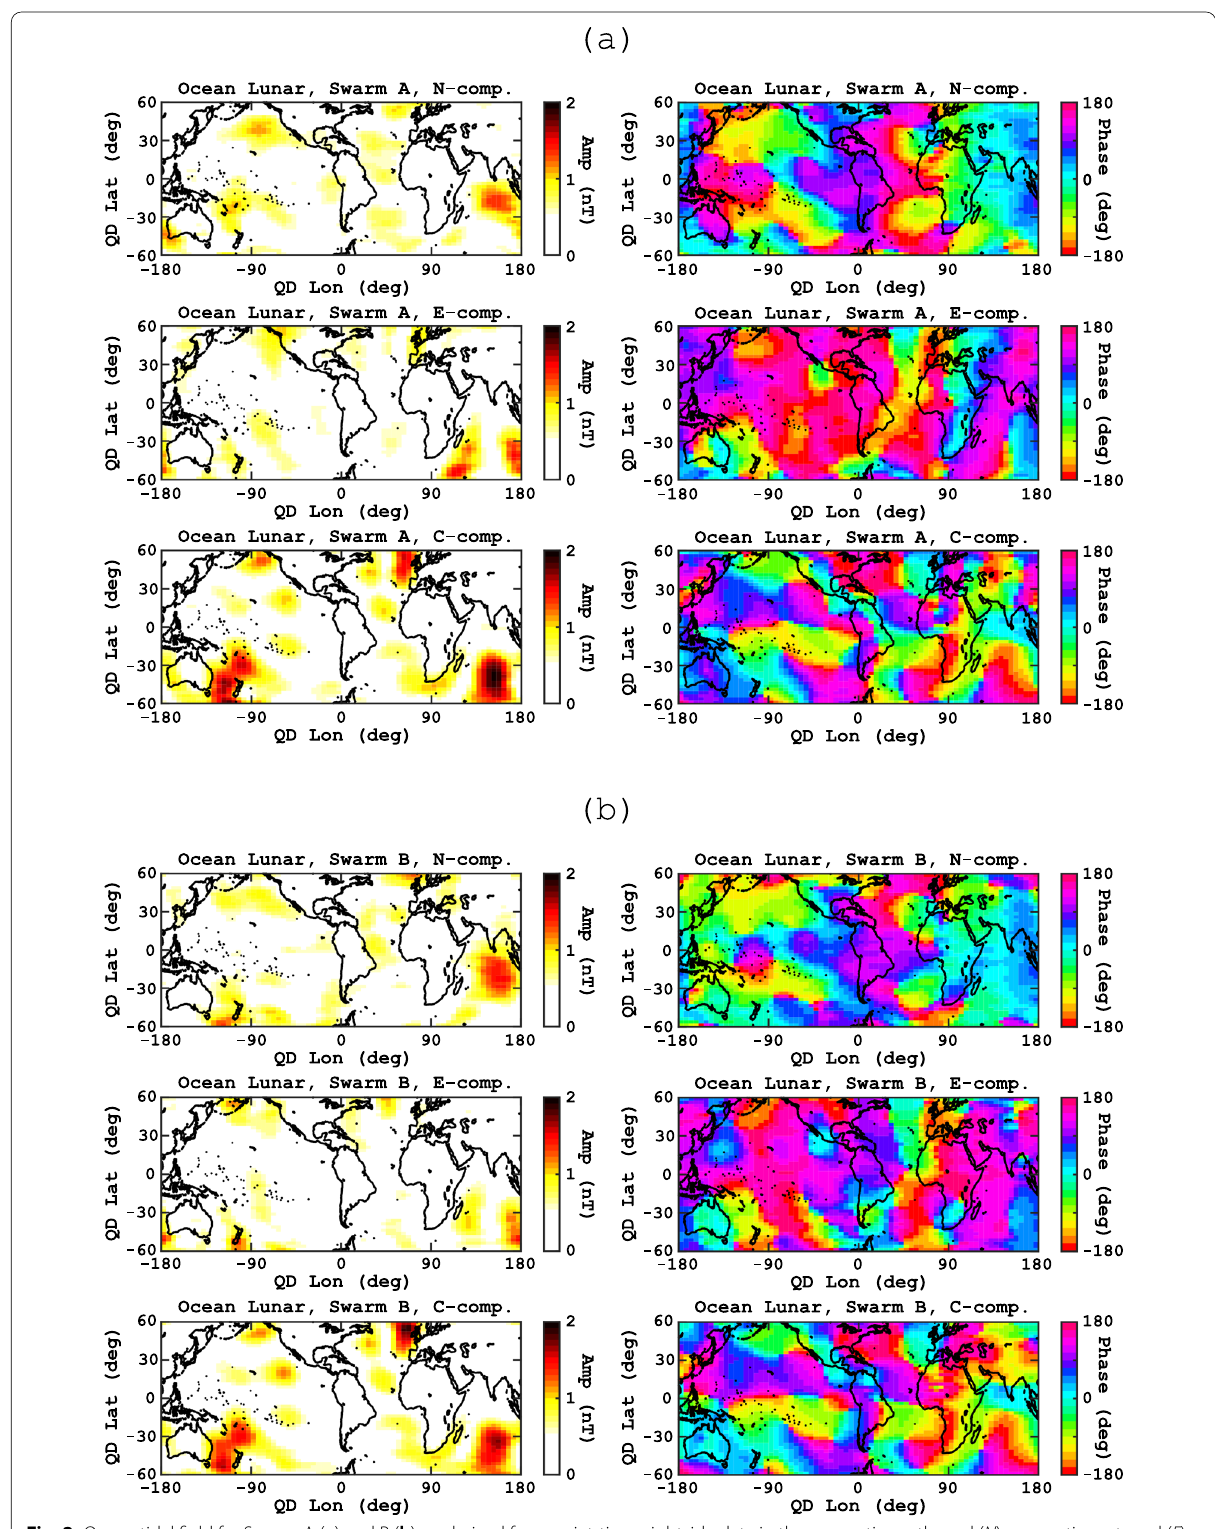
Fig. 2 Ocean tidal field for Swarm A ( a ) and B ( b ), as derived from quiet-time nightside data in the magnetic northward ( N ), magnetic eastward ( E ) and center ( C ) components during 2017–2020. Left panels show the amplitude, and right panels show the